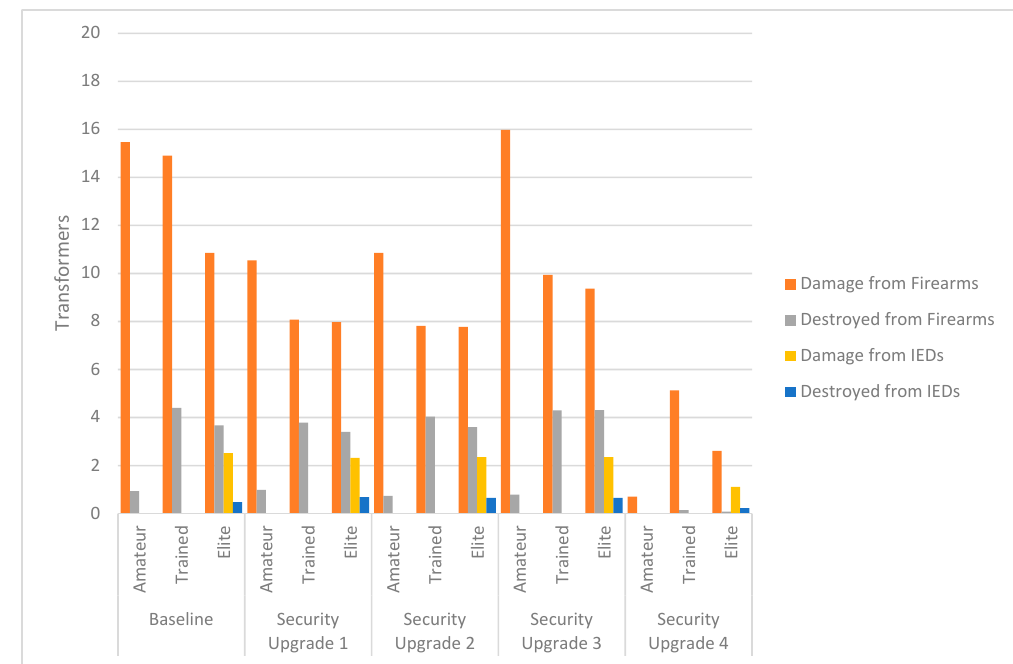
Figure 2. Damaged or Destroyed Transformers from a physical attack, based on Security Upgrade Level.